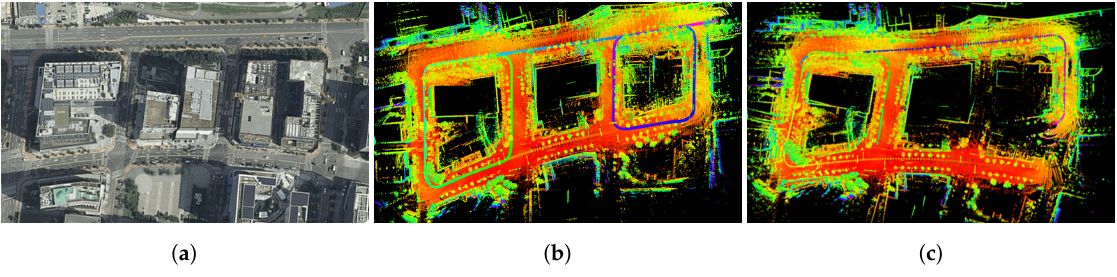
Figure 14. Results of the LiDAR approach in some section of course 2: (a) satellite image; (b) LiDAR odometry and mapping; (c) drift